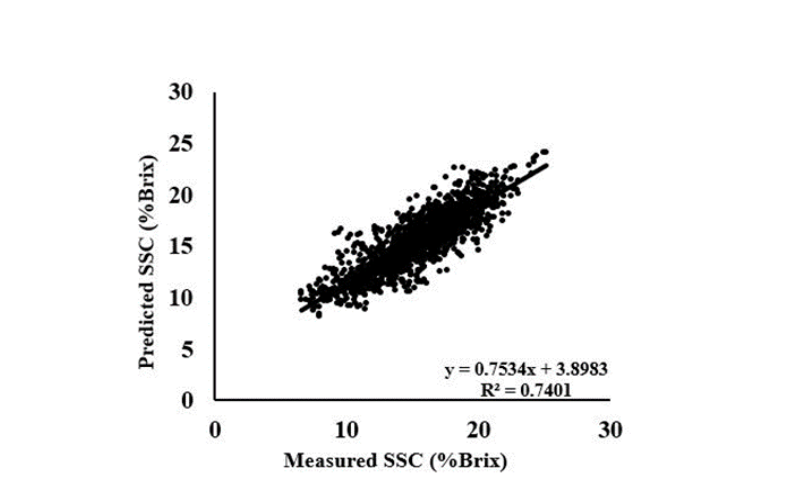
Figure 8. Scatter plots of measured versus predicted SSC using SVM-R method with